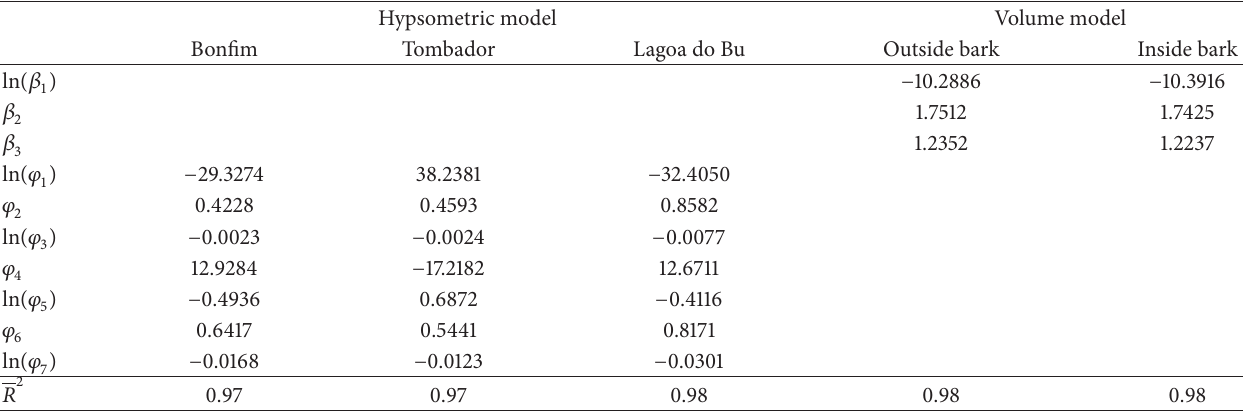
Table 1: Estimates of parameters and adjusted coefficients of determination ( 𝑅 height prediction (hypsometric) equations for each installation. All terms were significant at 𝛼 = 0.01